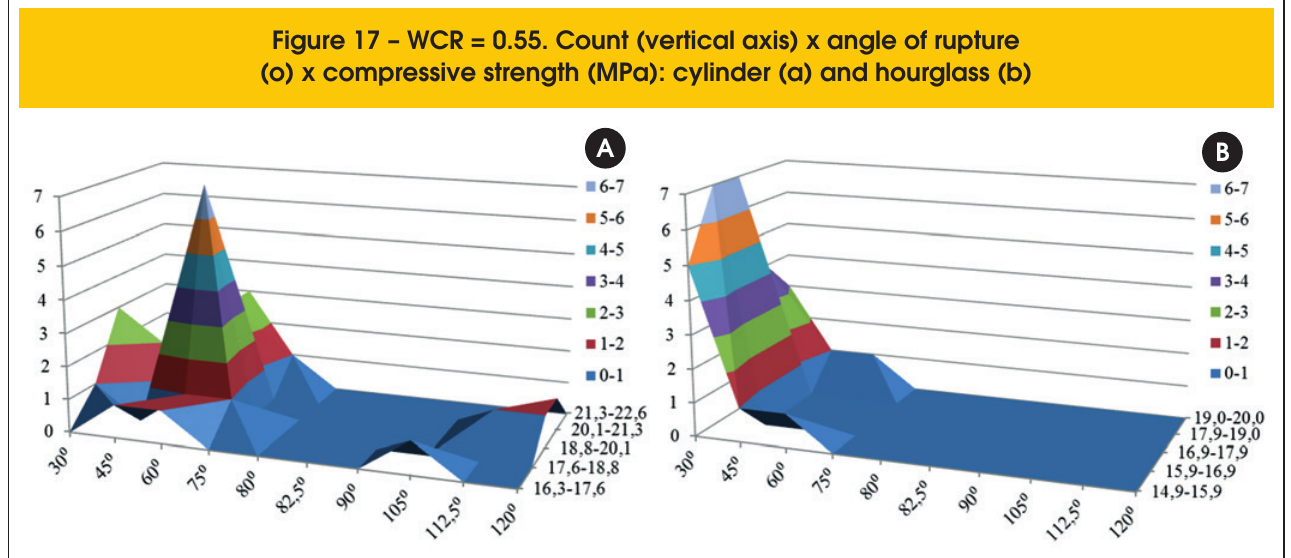
Figure 17 – WCR = 0.55. Count (vertical axis) x angle of